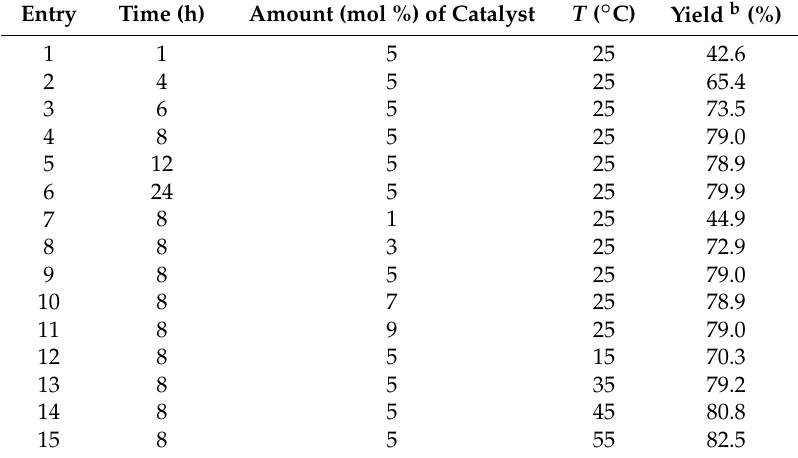
Table 3. Optimization of the parameters of the cyanosilylation reaction of benzaldehyde and TMSCN with catalyst 2 a